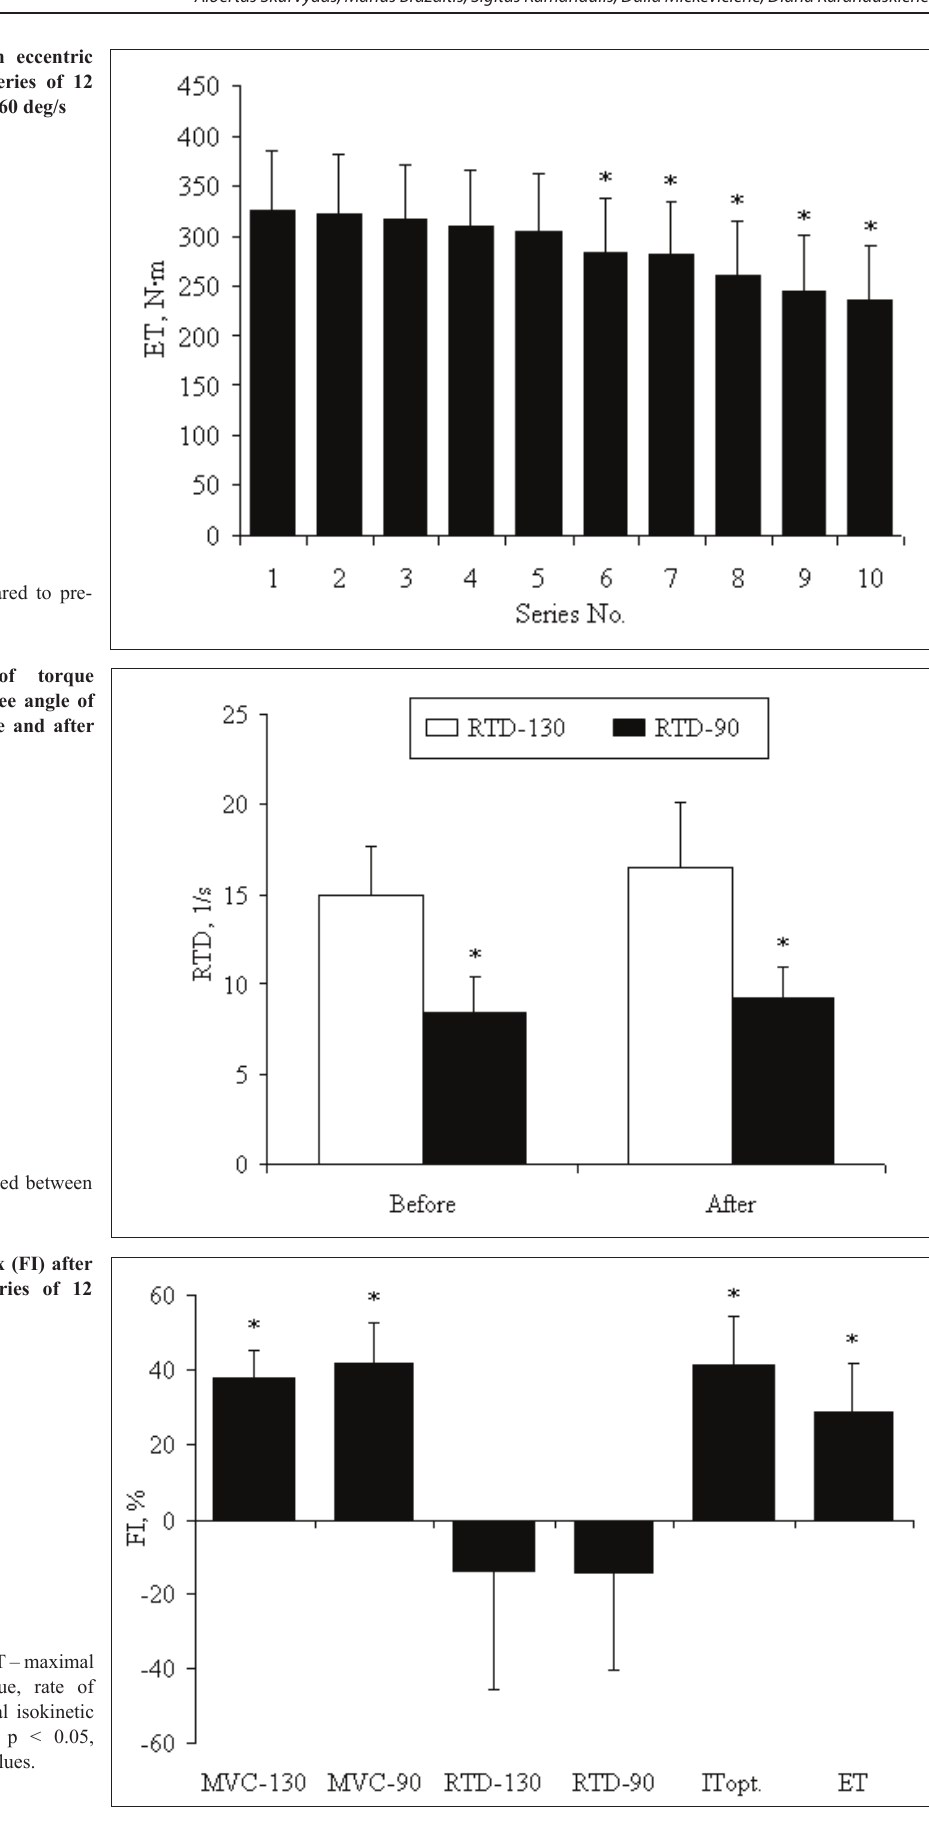
Figure 3. The fatigue index (FI) after eccentric exercise (10 series of 12 repetitions)